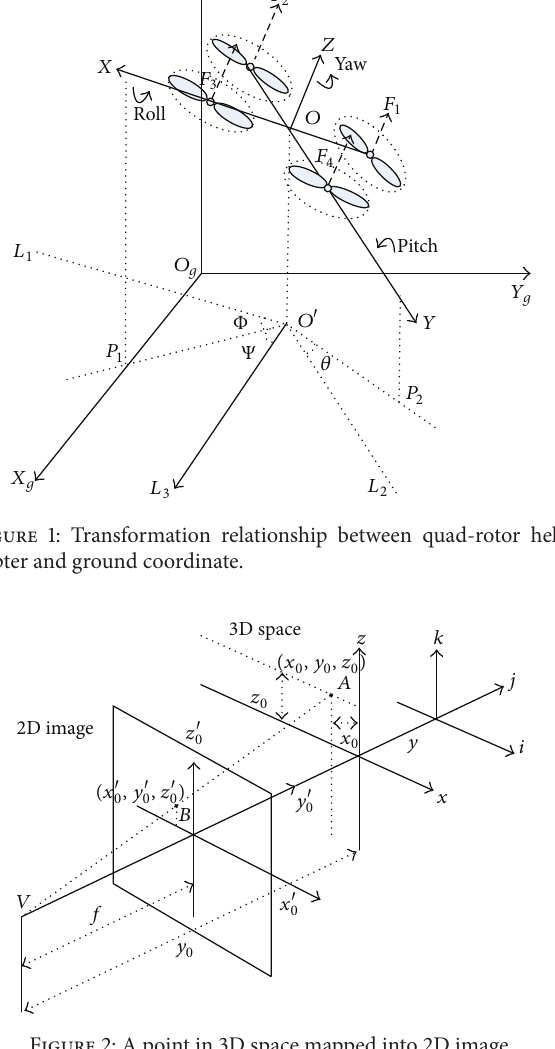
function and calculating max derivative through first order differential operator. The process of edge detection is used to delete much useless information. In fact, it is used to detect points having obvious brightness variation, because these points include much information such as discontinuous depth and surface direction, change of material attribute, and scene illumination. Canny algorithm includes the below 4